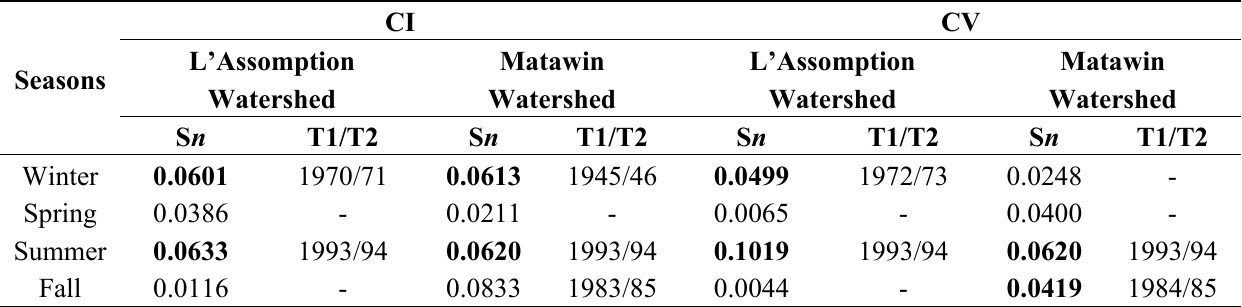
Table 2. Analysis of the temporal variability of two flow indices in the two watersheds using the Lombard test (1930–2008).